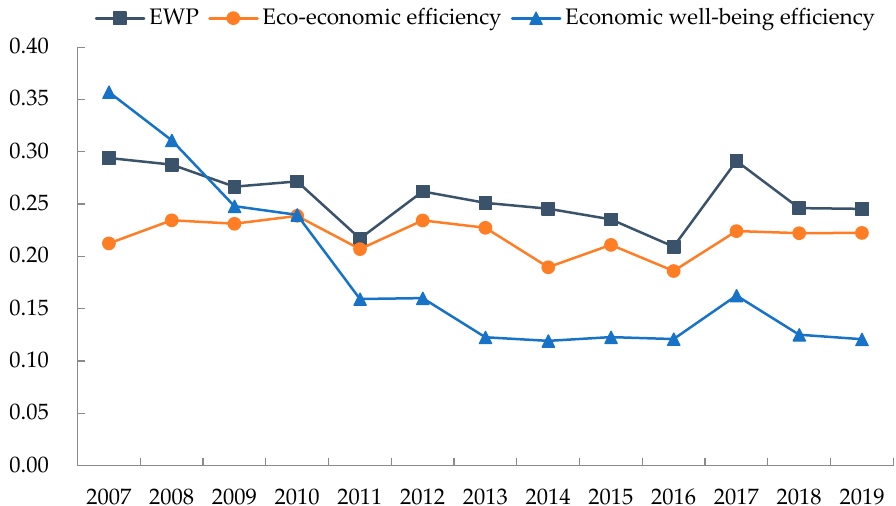
Figure 5. Dagum Gini coefficient of EWP and its phased efficiency in the Poyang Lake area.